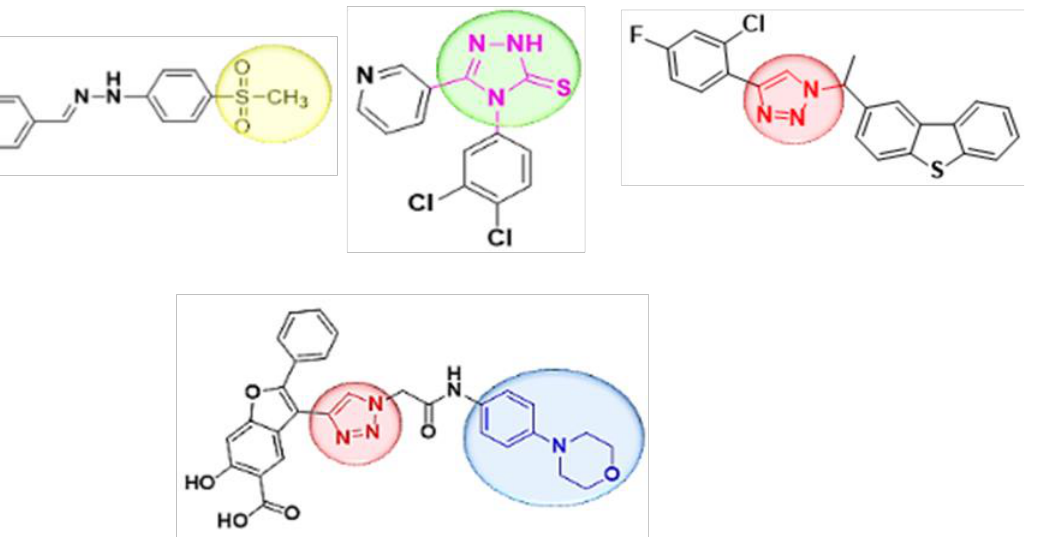
Figure 1. Representative structure of 1,2,3 and/or 1,2,4-triazole derivatives that exhibit anti-tubercular activity.